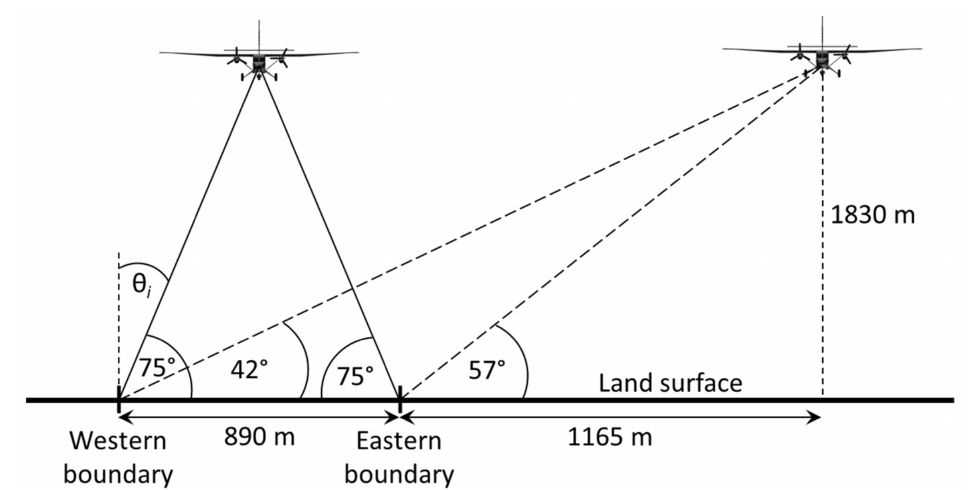
Figure 2. Multi-angle acquisition geometries at the Huntington Botanical Gardens (not to scale). For clarity, only one of the two opposing oblique scans is